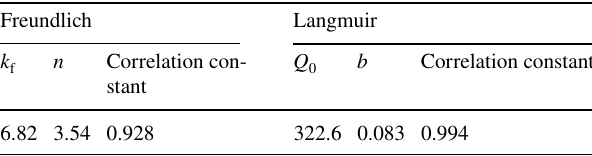
Table 1 Langmuir and Freundlich constants of absorption isotherms curves